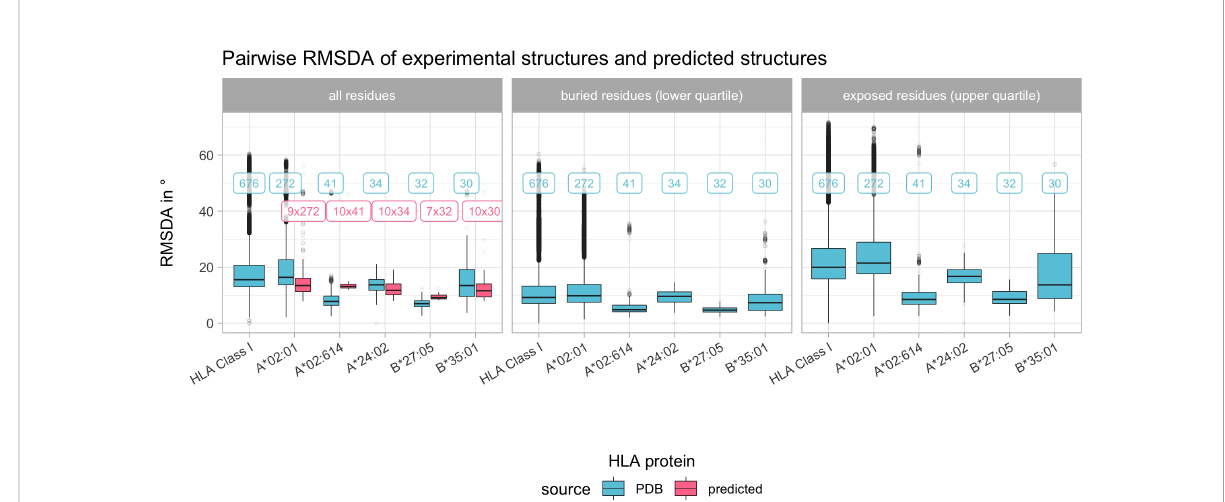
FIGURE 5 Boxplot indicating the pairwise root mean square dihedral angle differences (RMSDA) in degree across all experimental HLA Class I structures and pairwise across the most common HLA Class I structures. Color depicts the source of the structure data (blue indicates experimental structures from the PDB, pink indicates predicted structures as described in Materials and Methods). Horizontal panels consider separate distributions of all, only buried or only exposed residues. Boxplots depict the median (horizontal line), fi rst to third quartile (box); the highest and lowest values within 1.5× IQR (whiskers) and outliers (circles), respectively. Labels refer to the number of structures being compared, with blue labels referring to experimental structures and pink labels referring to predicted structures being compared with experimental